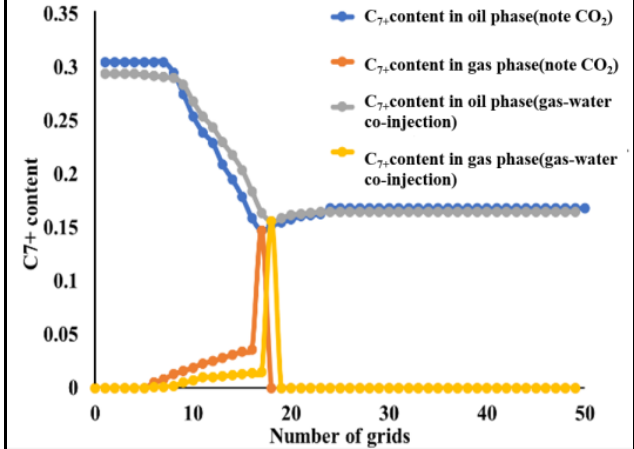
Figure 19. Molar fraction of C 7+ in oil and gas.